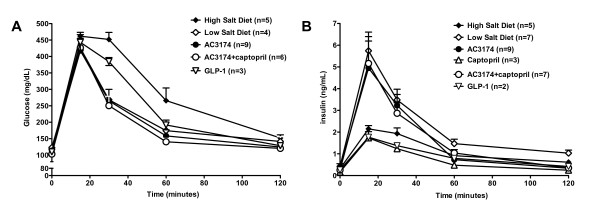
Beneficial effects of AC3174 on postprandial glycemic control after 4 weeks of treatment. (A) Serum glucose concentrations after an intraperitoneal bolus of glucose. No significant difference between the GLP-1 and high salt alone groups. At 30 min post-bolus, low salt, AC3174, GLP-1, and combination AC3174 plus captopril treatment significantly lowered glucose concentrations compared with high salt diet alone (P ≤ 0.05). At 60 min post-bolus, low salt, AC3174, and AC3174 plus captopril significantly lowered glucose concentrations compared with high salt diet alone (P ≤ 0.05). At 120 min post-bolus, AC3174 and AC3174 plus captopril significantly lowered glucose concentrations compared with high salt diet alone (P ≤ 0.05). No data were collected from the captopril group. (B) Serum insulin concentrations after an intraperitoneal bolus of glucose. A high salt diet lowered insulin concentrations at all post-bolus time points compared with a low salt diet (P ≤ 0.05). No significant difference between the GLP-1 and high salt groups. Captopril significantly lowered insulin concentrations at 30, 60, and 120 min post-bolus compared with a high salt diet (P ≤ 0.05). Treatment with AC3174 (alone or with captopril) significantly raised insulin concentrations at 15 and 120 min post-bolus compared with high salt diet alone (p < 0.05). *P ≤ 0.05 versus high salt diet. N = 3 to 14 rats per group. Mean ± SEM.